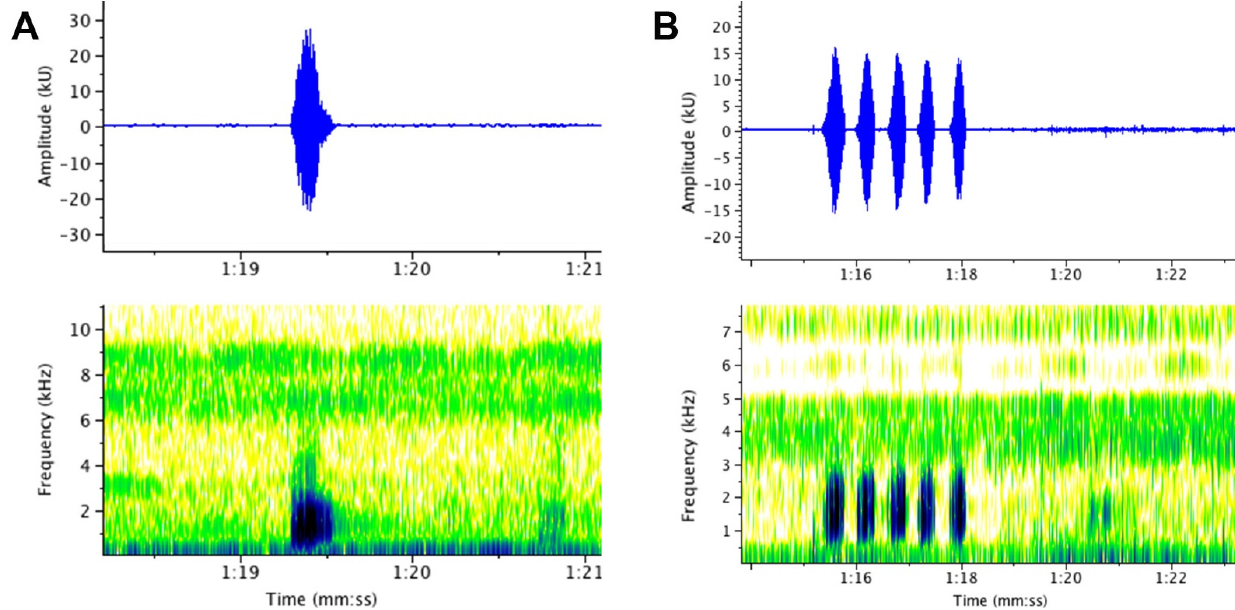
Figure 7. Advertisement calls of male Limnonectes . ( A ) P. bagoyoma n. sp. , SMF 106035 ( B ) L. limborgi , GK-7209. See text for details and Figure 6 for localities plotted on map.